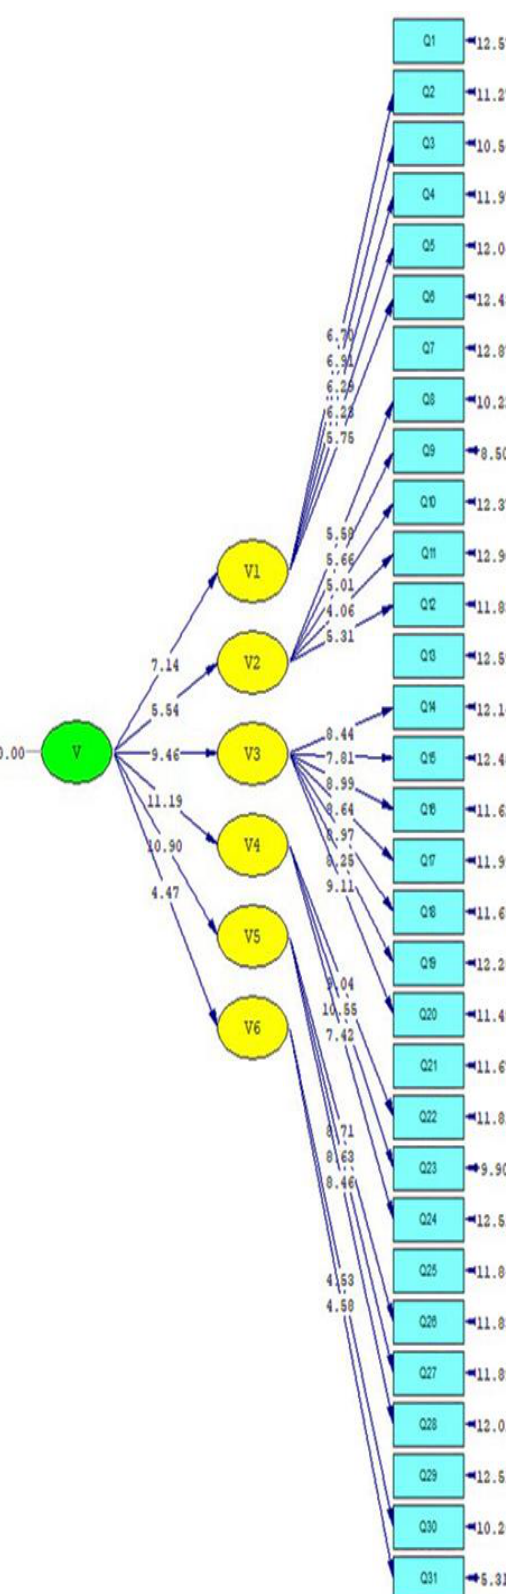
Fig. 4. t-values of the path diagram. Fig. 3. Standardized model of confirmatory factor analysis by